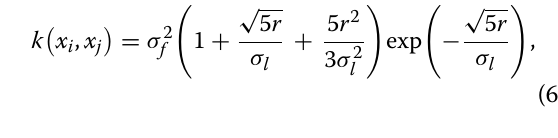
*Predictor variable selected after Step